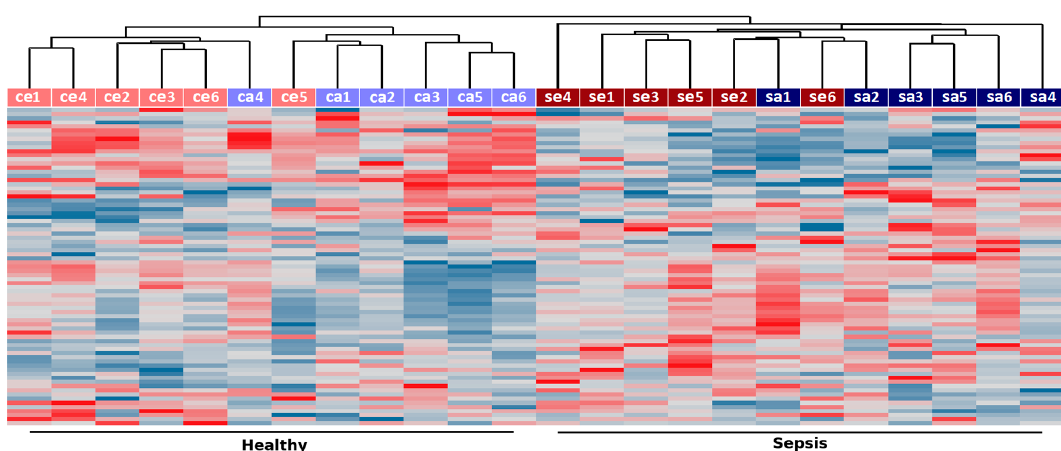
Figure 1. Unsupervised hierarchical clustering of samples from sepsis (“se” for elderly and “sa” for adults) and healthy controls (“ce” for elderly and “ca” for adults) based on long noncoding RNA (lncRNA) expression. Expression measurements from the top 5% more variable lncRNAs (based on their coefficient of variation across all samples) were used to group samples using UPGMA clustering and Pearson correlation as a distance measurement. Samples are labeled according to disease status (sepsis in red, healthy controls in blue) and age (elderly subjects are shown in darker colors whereas those from young adults are shown in lighter colors).